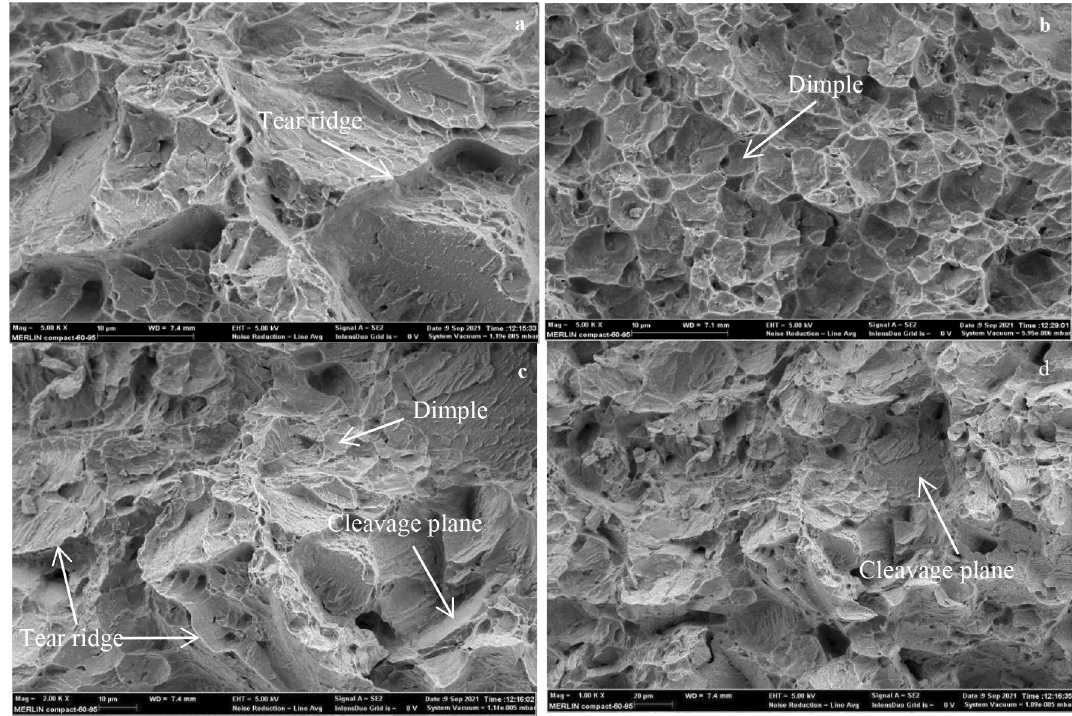
Fig. 8 SEM photograph of the tensile fracture: a , c tear ridges; b , c , d dimples; c , d cleavage planes